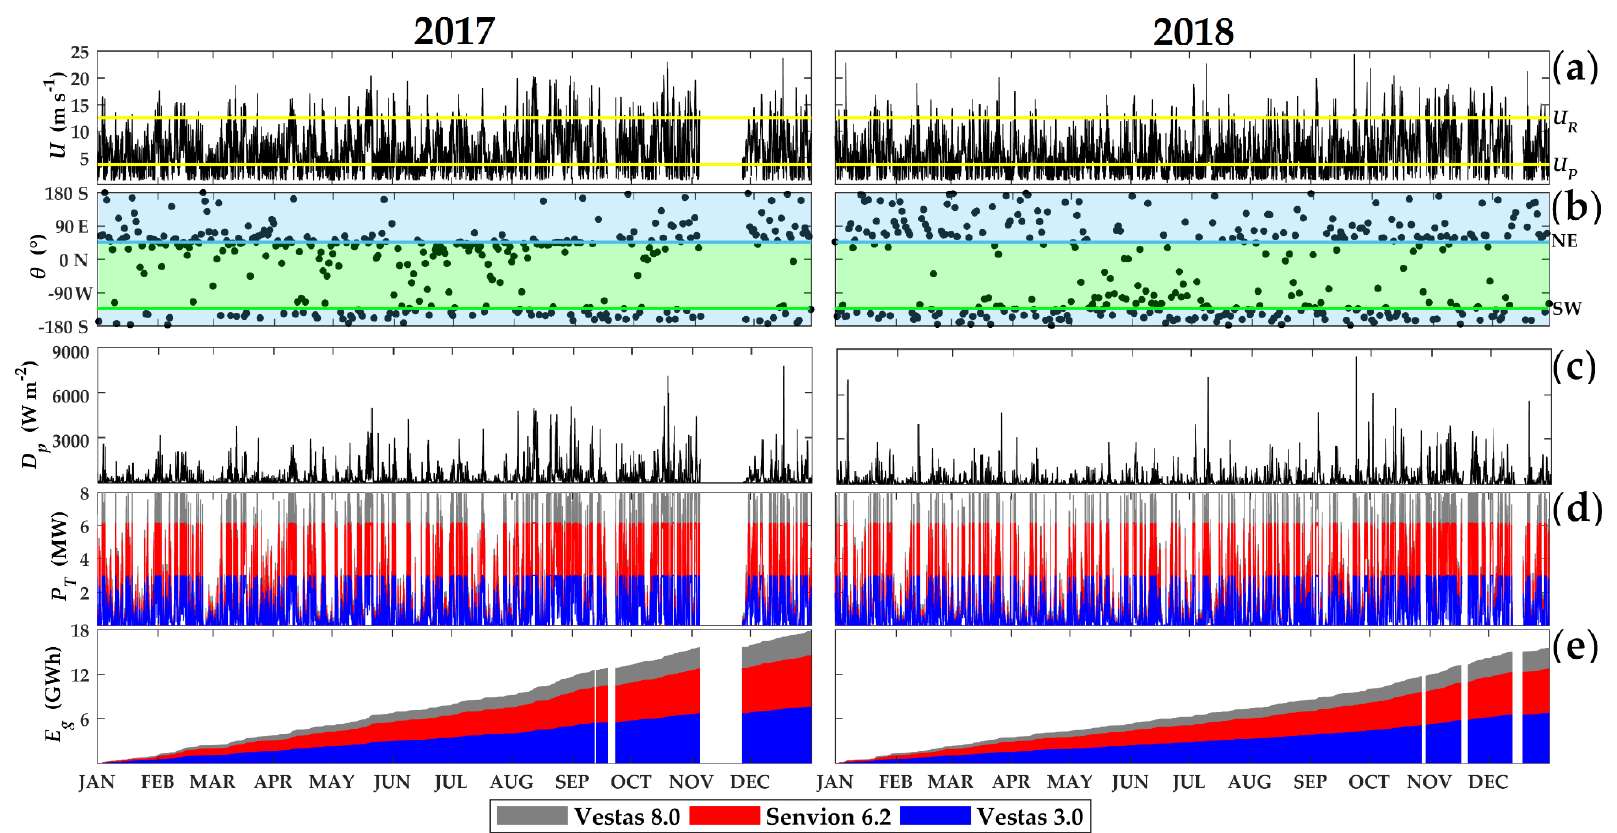
Figure 3. Wind variability and wind resource for 2017 (left panels) and 2018 (right panels). ( a ) Horizontal wind speed U at a height of 110 m. The solid yellow lines indicate the cut-in speed ( U P ) and rated speed ( U R ) of modern wind turbines. ( b ) Wind directions θ at 110 m height is represented by black dots. The direction follows the meteorological convention (direction from which the wind blows) and the true north is indicated by 0 ◦ N. A blue line indicates the NE (45 ◦ ) direction. A green line indicates the SW ( − 135 ◦ ). A light blue shade indicates winds from the ocean sector. A light green shade indicates winds from the continental sector. ( c ) Wind power density D p . ( d ) Turbines output P T . ( e ) Energy generated E g . A time resolution of 10 min is displayed in panels ( a , c – e ). Daily averages are used in ( b ) for a better visualization.